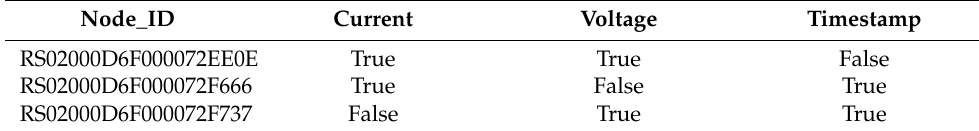
Table 2. SENSOR_COLUMN table.